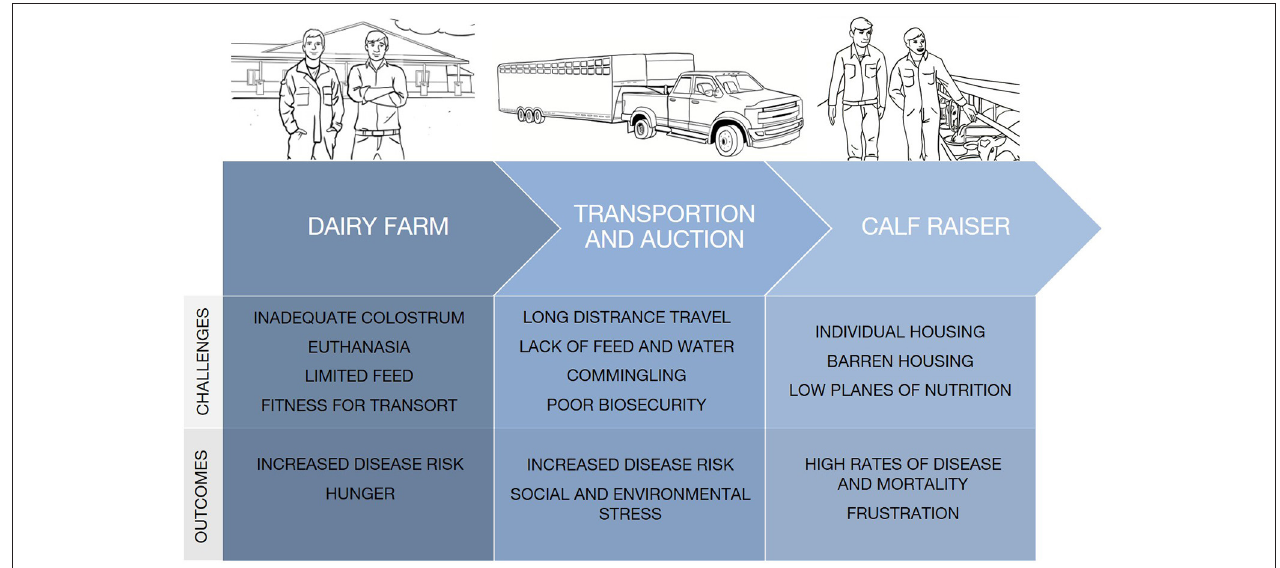
FIGURE 1 | Challenges surplus calves experience from birth through early life management. Surplus calves frequently receive poor care on dairy farms of origin, then many calves are transported long distances and may be marketed through livestock auctions before arriving at the calf raiser. Each stage of the surplus calf production system presents unique challenges to calf health, affective states, and the ability to perform natural